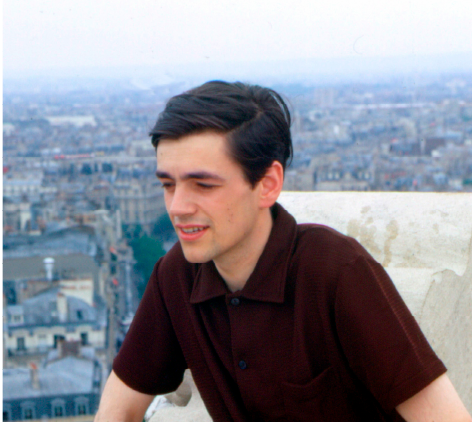
Figure 1. Geoff A Parker in 1967 during his PhD at University of Bristol.